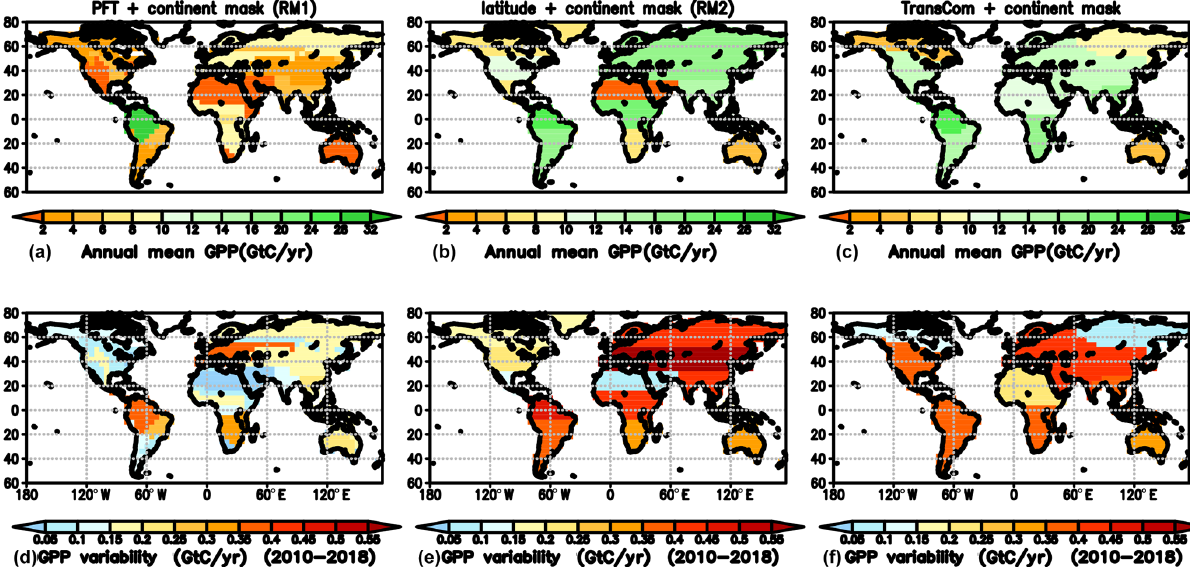
Figure B4. Regional mean FLUXSAT GPP and its variability between 2010–2018. (a, b, c) Regional mean GPP aggregated with the three regional masks; (d, e, f) GPP variability between 2010–2018. Unit: